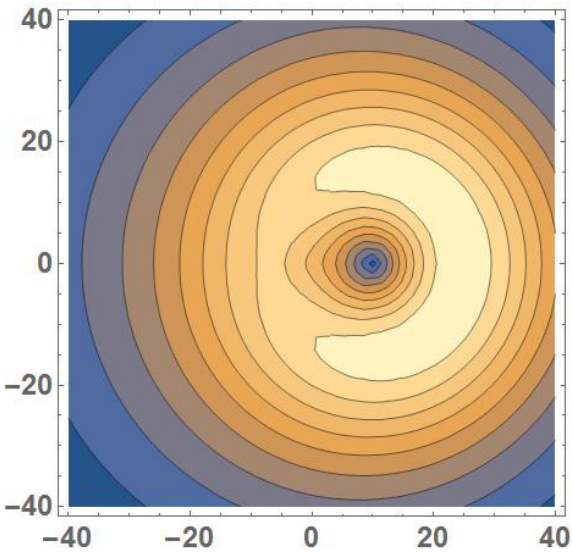
Figure 5. Contour plot for the apparent dark mass distribution in an ideal galactic cluster with two components located at x = 0, y = 0, and x = 10, y = 0. The largest baryonic point-like mass is at the origin of coordinates and the other is only a fraction (0.3) of the larger one. Notice that the larger densities of apparent dark matter (depicted in yellow) are located to the right of the smaller visible component and, consequently, the apparent center of mass is displaced with respect to the center of mass of the visible